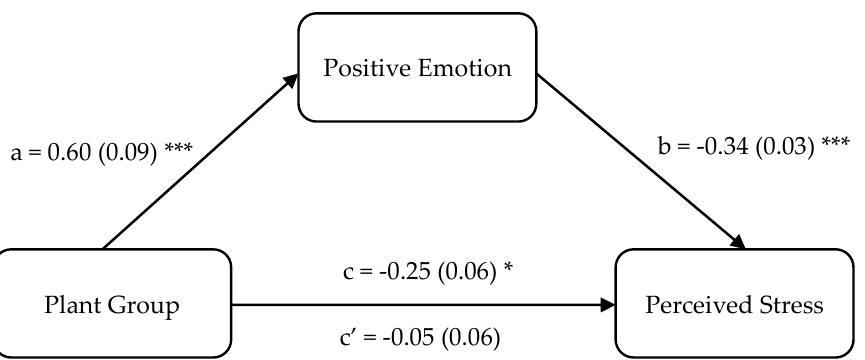
Figure 2. Mediation regression analysis results of the plant group predicting the perceived stress. *, *** represent p < 0.05, p < 0.001, respectively.